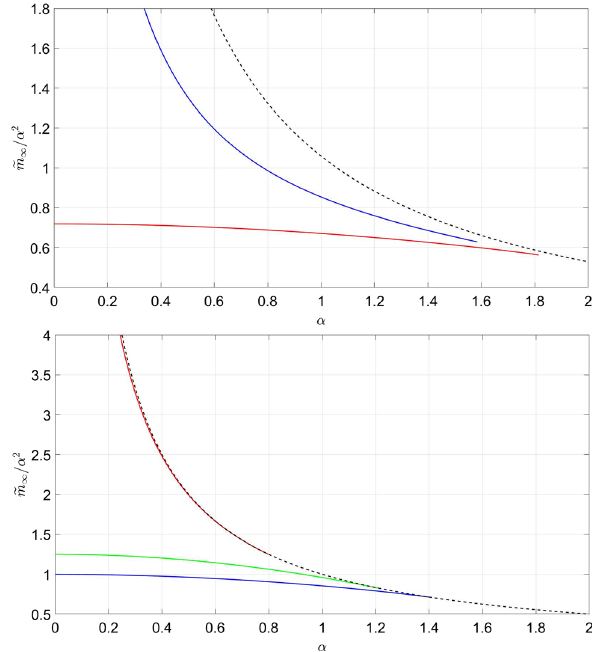
Fig. 3 Top: Plot of (cid:13) m ∞ /α 2 versus α for gravitating monopole (red), radialexcitation(blue)andtheextremalRNsolution(dashedline)ofthe EWS theory. Bottom:Plot of (cid:13) m ∞ /α 2 versus α for gravitatingmonopole (blue),radialexcitation(red)andtheextremalRNsolution(dashedline) of the EYMH theory when β = 0. Green line represents the gravitating monopole when β = 0 . 77818833